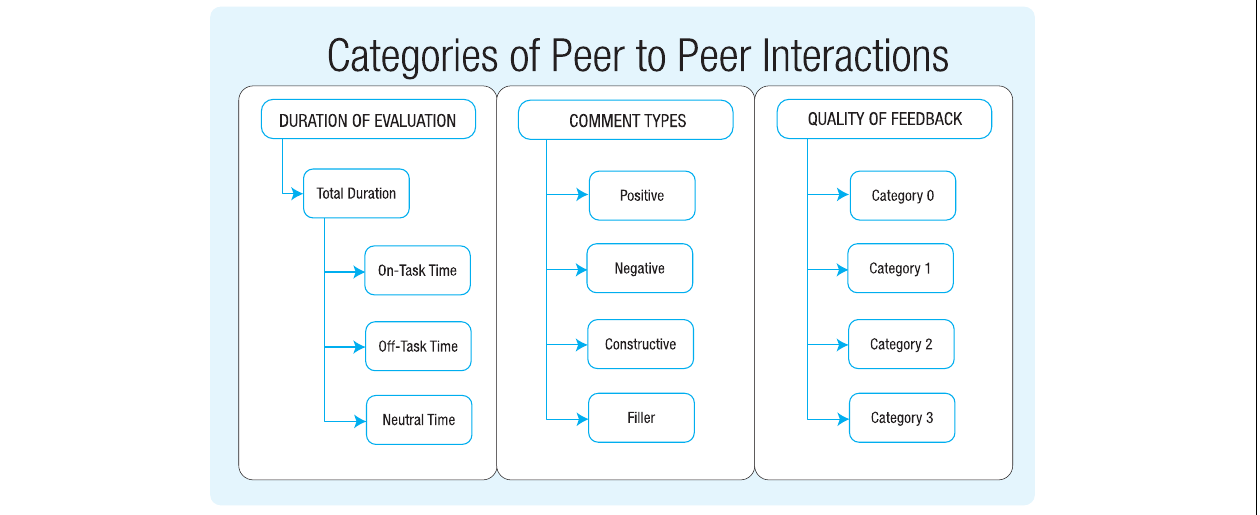
FIGURE 2 | Coding scheme used to evaluate peer evaluation and discussion interactions between